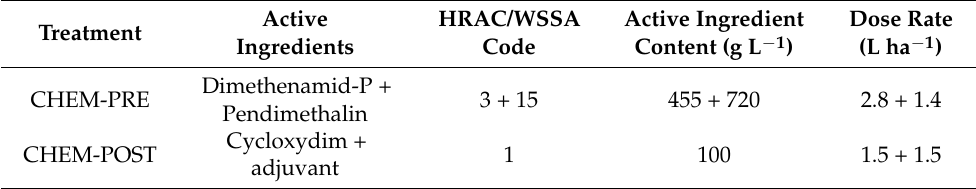
Table 4. Active ingredients, HRAC/WSSA code 1 , active ingredient content, and dose rates of the chemical herbicides treatments. 1 Herbicide Mechanism of Action According to the Herbicide Resistance Action Committee (HRAC) and Weed Science Society of America (WSSA)